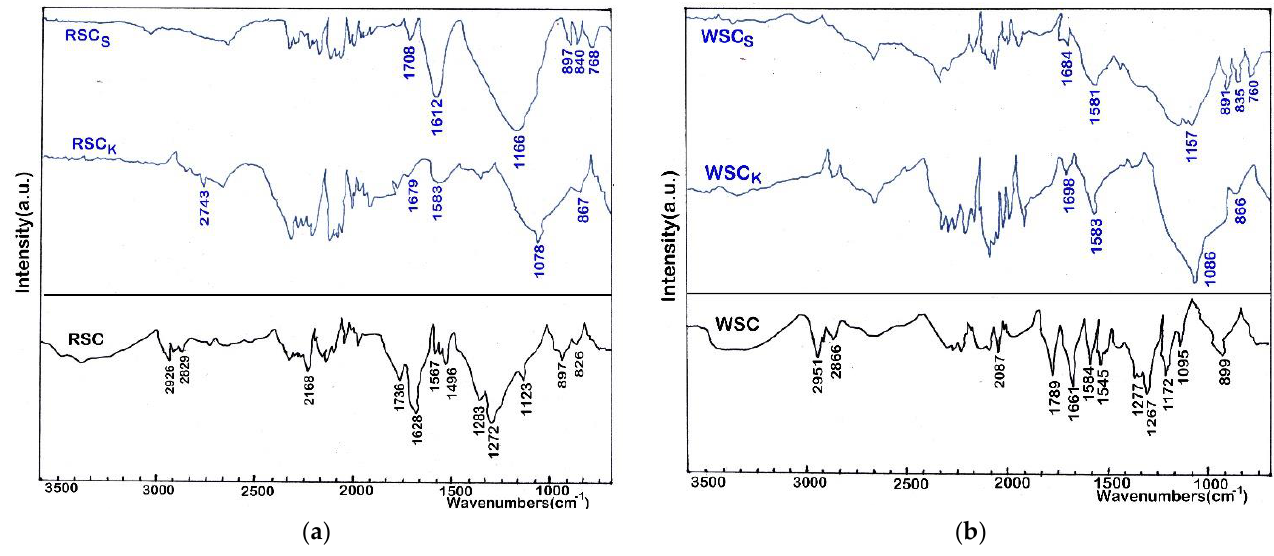
Figure 3. FTIR spectra of biochar: ( a ) biochar and activated biochars prepared from rapeseed cake; ( b ) biochar and activated biochars prepared from walnut shells.